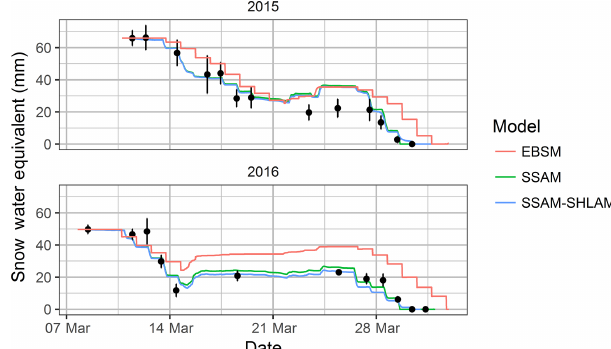
Figure 11. Snow water equivalent simulation for EBSM (red line), SSAM (green line) and SSAM–SLHAM (blue line) with respect to snow survey mean (black points) and 95% percentile sampling confidence interval (black lines).